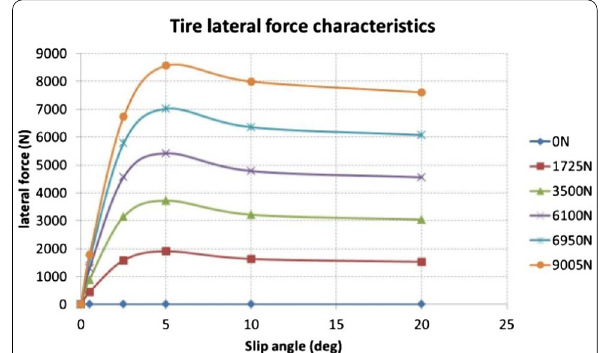
Figure 2 Tire lateral force characteristics